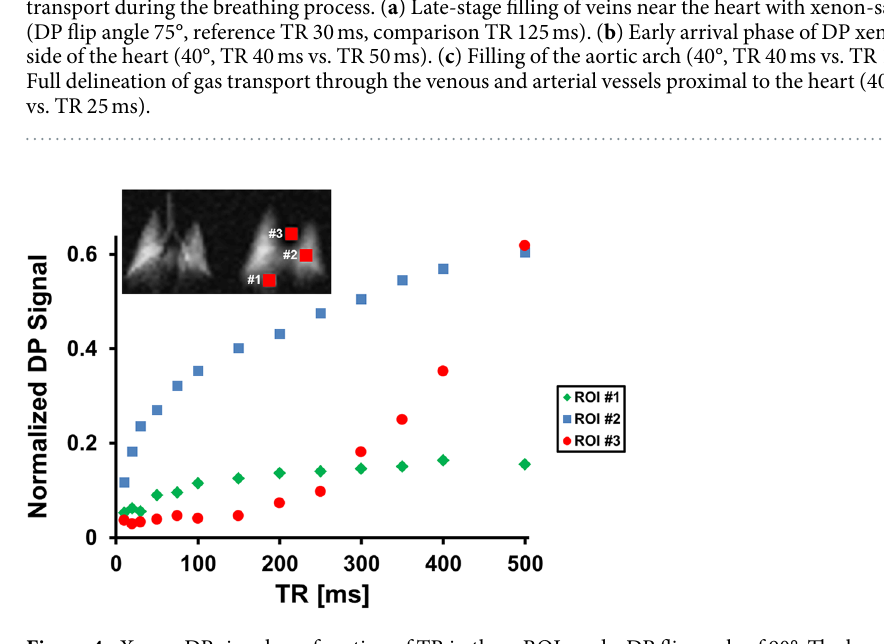
Figure 4. Xenon DP signal as a function of TR in three ROIs and a DP flip angle of 90°. The location of the ROIs relative to the DP lung image is illustrated in the insert. The ROIs exhibit distinct signal characteristics that reflect regional differences in gas uptake and